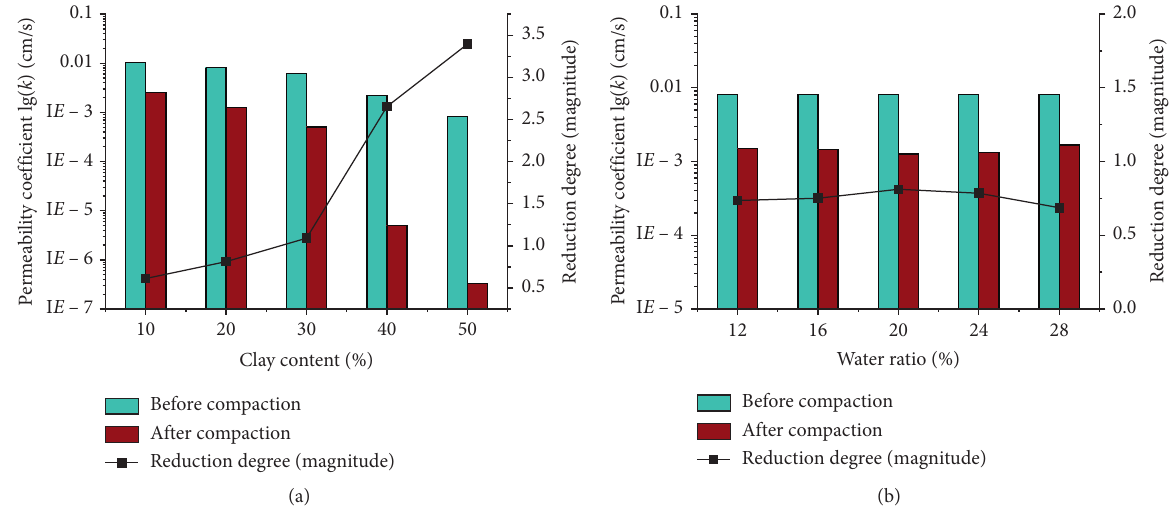
Figure 16: Comparison of permeability coefficient before and after compaction ( p � 2MPa). (a) At different clay contents. (b) At different initial water ratios.